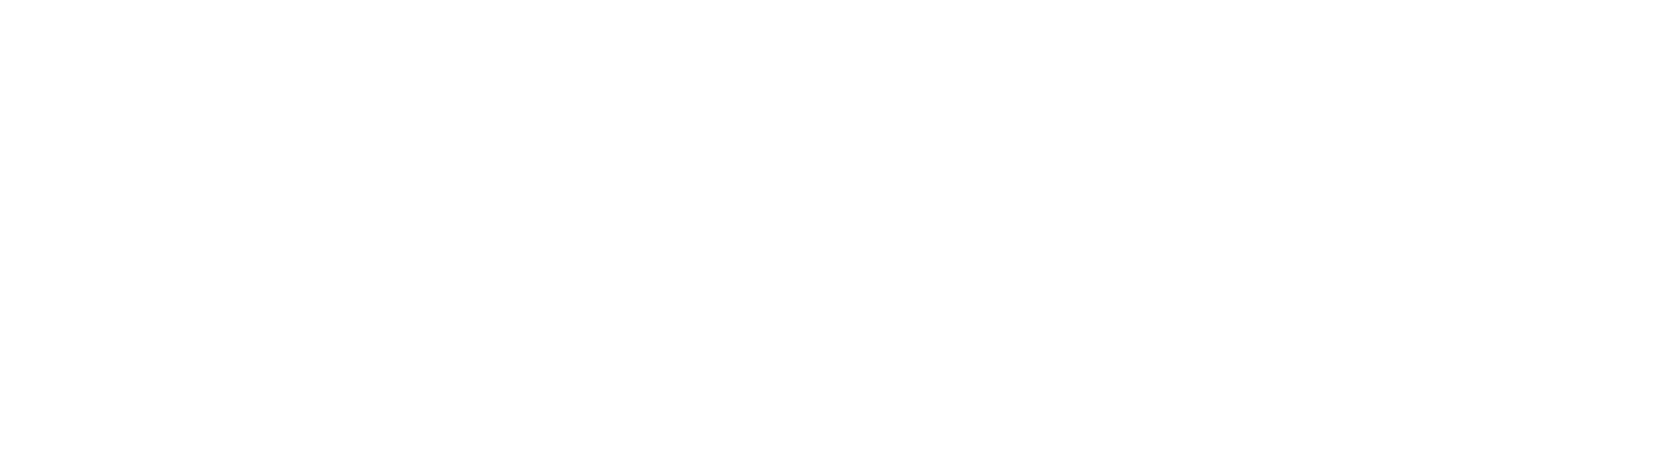
FIGURE 3 | Associations between the ADAMTS14 expression (FPKM) and ( A ) age, (B) gender, (C) grade, (D) stage, (E) staged T, (F) staged M, and (G) staged N in TCGA ccRCC